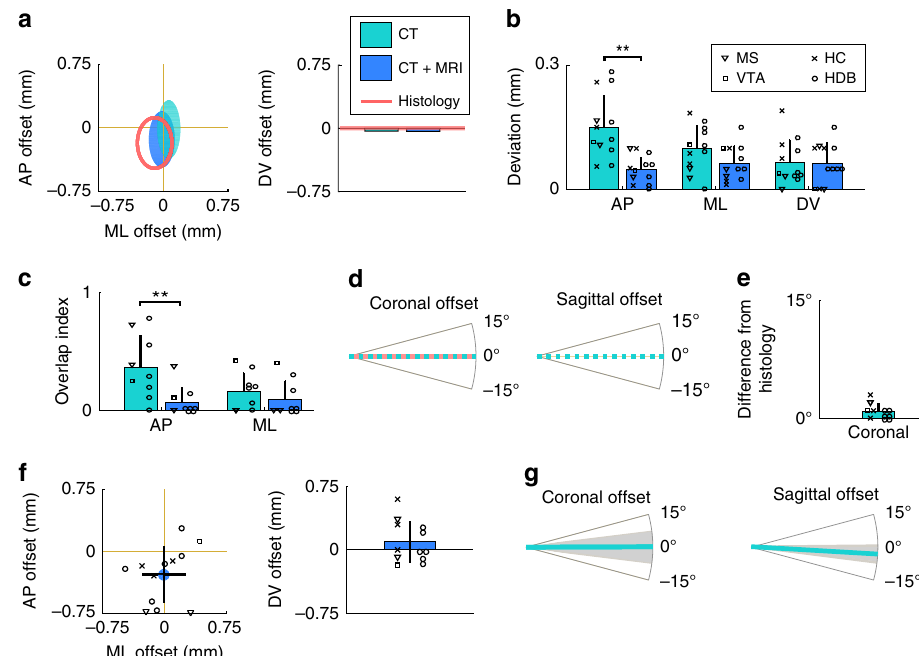
Fig. 8 Quanti fi cation of localization accuracy. a Anteroposterior (AP), mediolateral (ML), and dorsoventral (DV) offset from the target coordinate for an example animal. Teal, CT-based coordinate system alignment; blue, CT – MRI fusion-based atlas co-registration; salmon, histological track reconstruction. Ellipses on the left represent the area covered by the tip of the implant in the horizontal plane. b Mean absolute difference of tip coordinates in three directions with respect to histology. CT – MRI fusion-based localization was signi fi cantly closer to histology results in the AP direction. ** P < 0.01; P = 0.0024; two-tailed Wilcoxon signed-rank test. Individual data points ( n = 12 implants) are shown with different symbols representing target areas. c Mean distance from histology based on the overlap of implanted areas for tetrode implants. CT – MRI fusion-based localization was signi fi cantly closer to histology results in the AP direction. ** P < 0.01; P = 0.0078; two-tailed Wilcoxon signed-rank test. Individual data points ( n = 9 implants) are shown with different symbols representing target areas as in panel b . d Coronal and sagittal offset from the planned direction of the trajectory for the same example animal as in panel a . Implant directions were quanti fi ed based on the CT images. Histology only provides coronal offset measures. e Mean absolute difference of CT- based coronal angle compared to histology. Individual data points ( n = 12 implants) are shown with different symbols representing target areas as in panel b . f Mean offset from the target of the centroid of the localized areas with CT – MRI fusion-based localization. Individual data points ( n = 12 implants) are shown with different symbols representing target areas as in panel b . g Mean offset from the coronal ( n = 12 implants) and sagittal ( n = 11 implants) target direction with CT-based localization. Anterior, lateral, and ventral directions were de fi ned as the positive directions. Error bars and gray shadings in panel g show mean ± standard deviation.